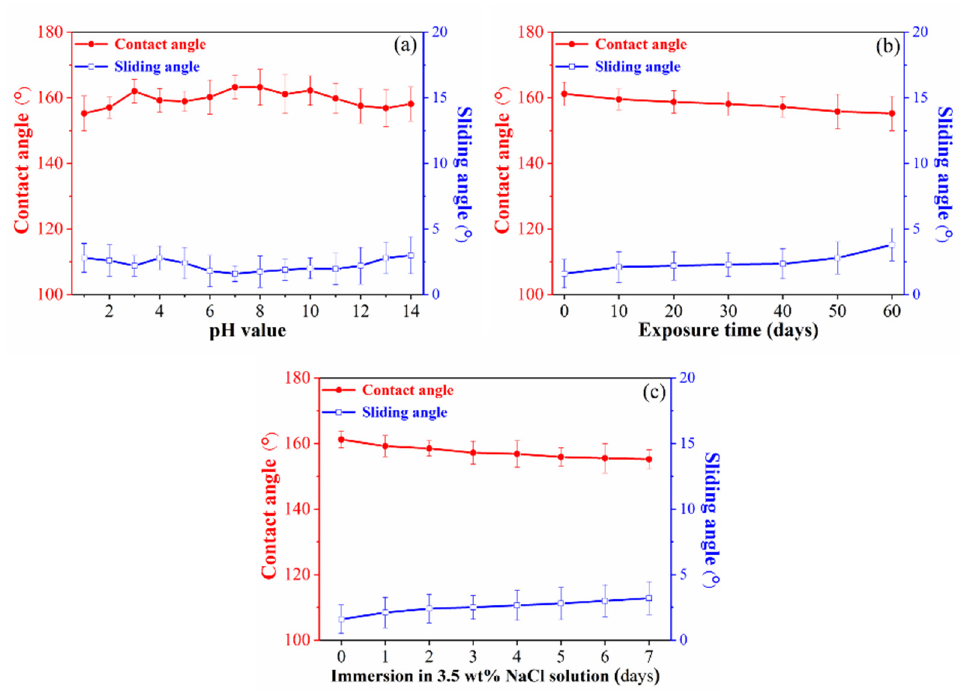
Figure 5. The CA and the SA of the superhydrophobic surfaces ( a ) under pH value, ( b ) exposure to air, and ( c ) immersed in 3.5 wt % NaCl solution).